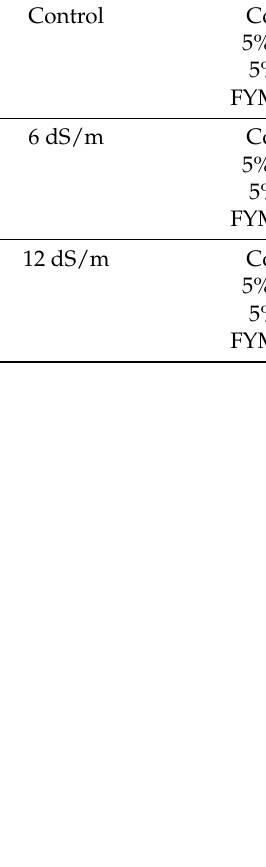
Table 4. Effect of different organic amendments on yield traits under diverse salt stress